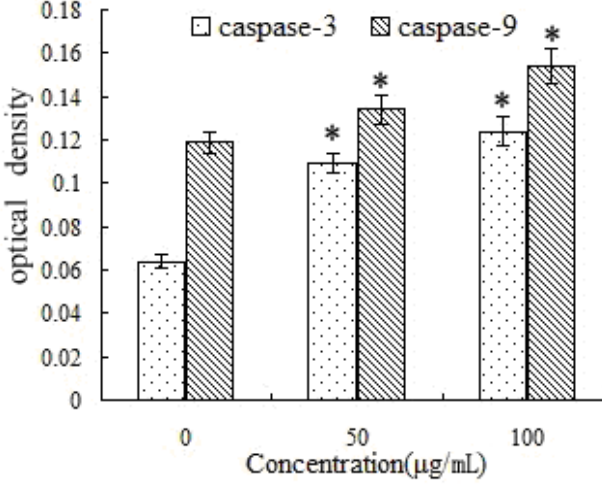
Figure 8. Effects of SFE-CO extract for regulating caspase-9 and caspase-3 in 2 SMMC-7721 cells. The results are expressed as the mean ± S.D. of three independent experiments. *p < 0.05, p value compared with the control